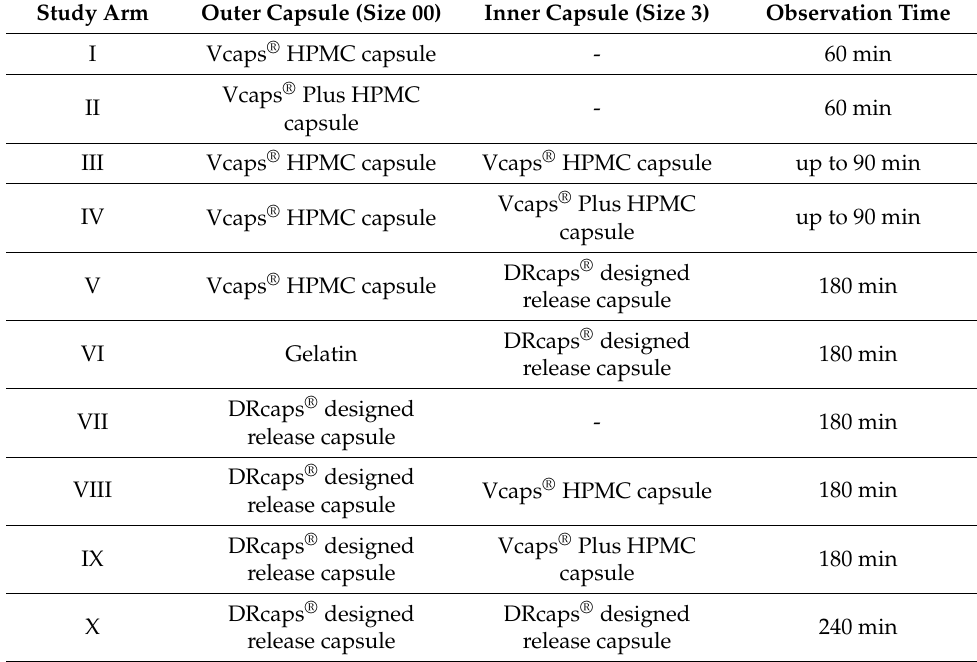
Table 1. Study arms and respective evaluation times.